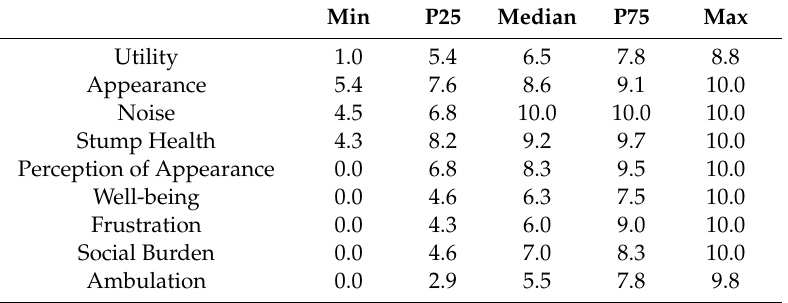
Table 2. Descriptive statistics of the various domains of the Prosthesis Evaluation Questionnaire (PEQ).